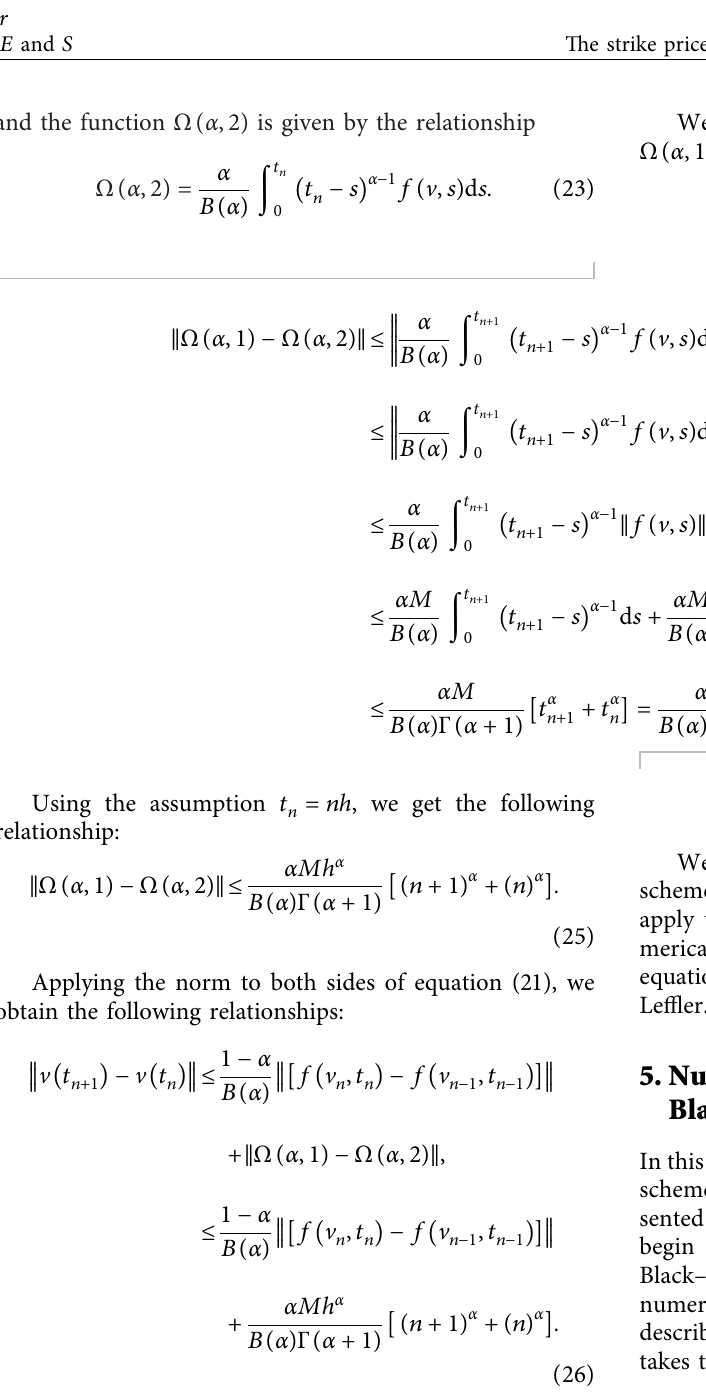
Table 1: Parameters of the Black–Scholes equation. The value of an option and the expiration time, respectively. The volatility of the underlining stock.